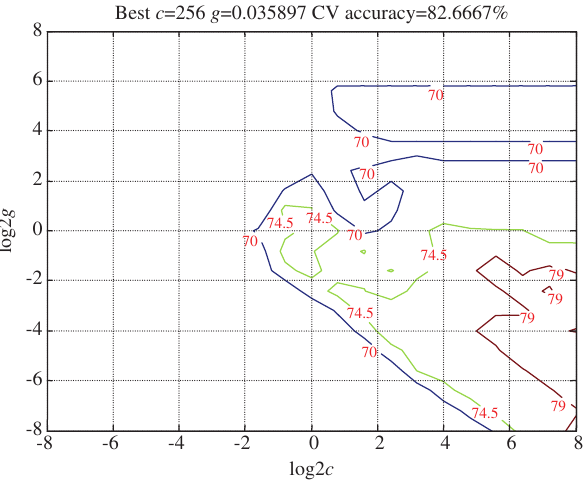
Figure 6: The Optimized Results of the Fifth Group of Experiments.